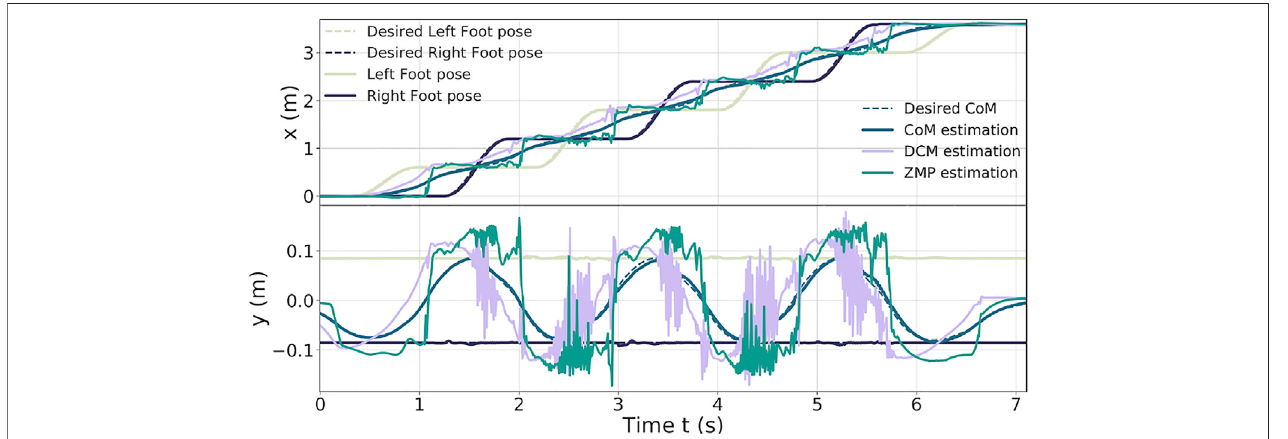
FIGURE 6 | Feet, CoM, DCM, and ZMP of the 60-cm step walk.